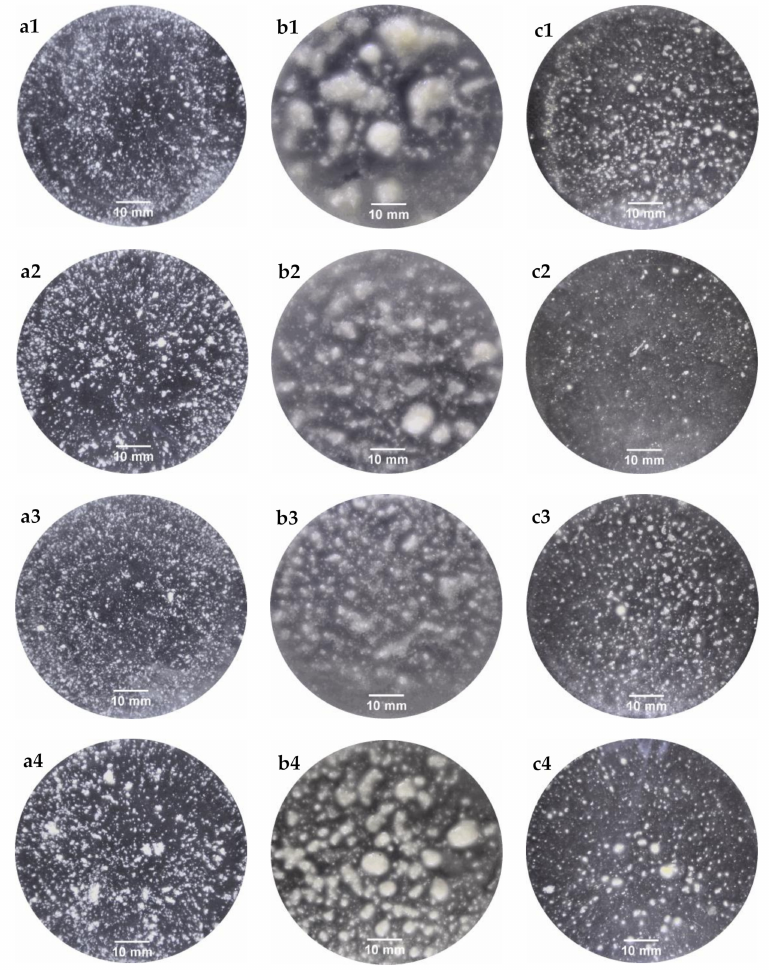
Figure 2. Representative images of bolus particles obtained after oral ( a ), gastric ( b ) and intestinal ( c ) in vitro digestion. Boluses were obtained from loaf bread ( 1 , 2 ) or bread rolls ( 3 , 4 ) using Ultra Turrax ( 1 , 3 ) or Ultra Turrax with crystal balls ( 2 , 4 ) as simulated oral processing